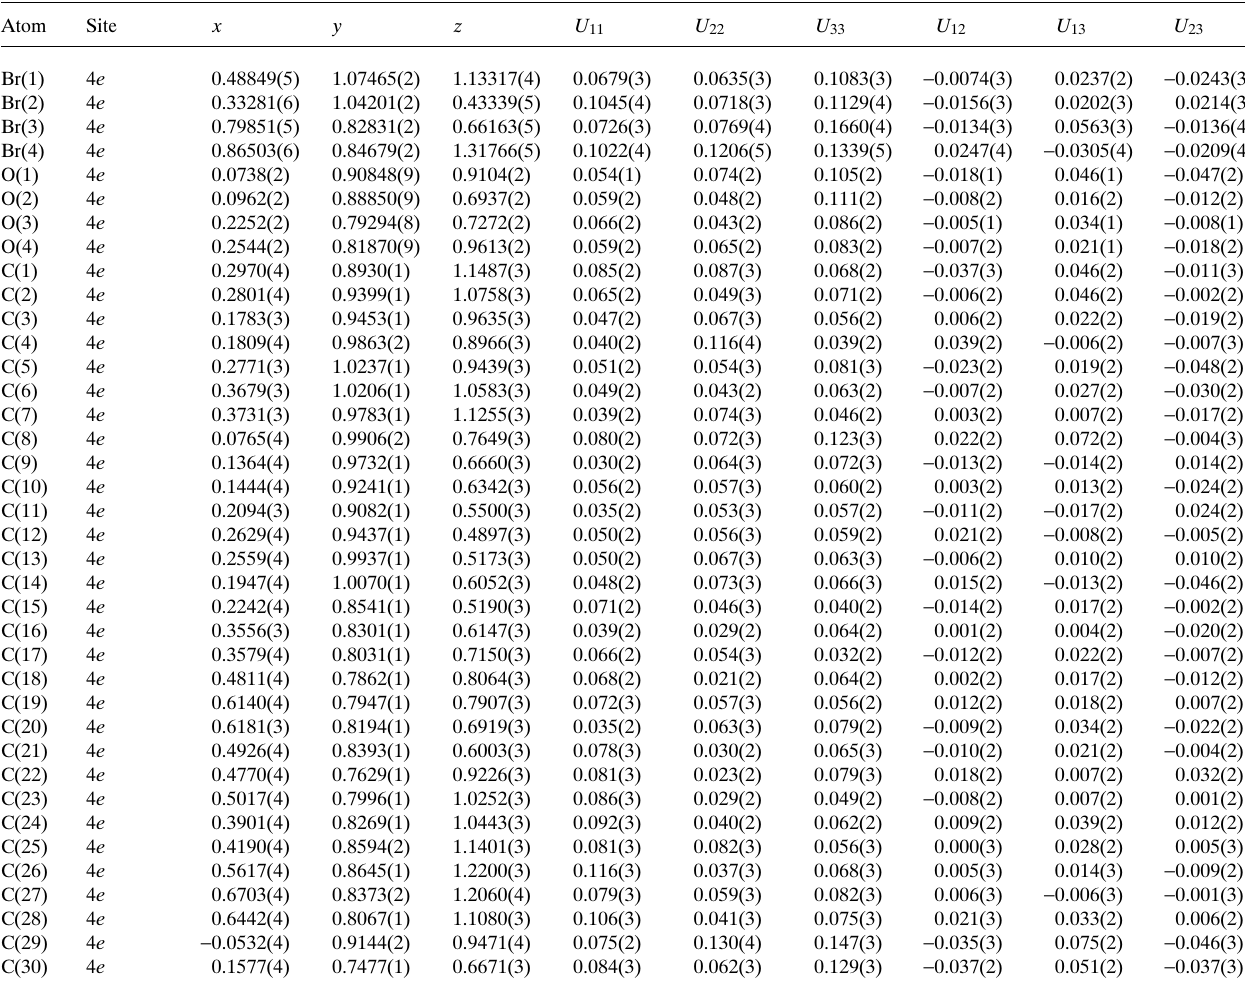
Table 3. Atomic coordinates and displacement parameters (in Å 2 )